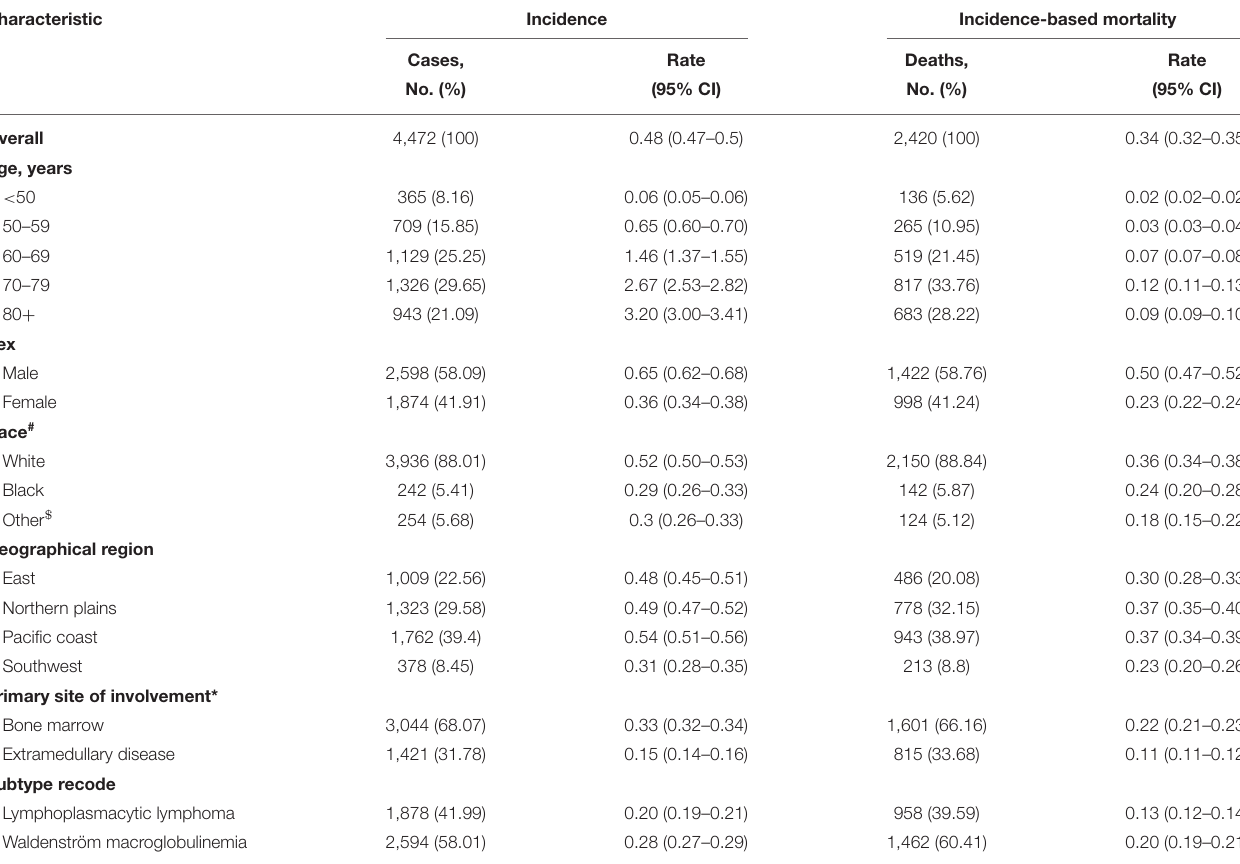
TABLE 1 | Waldenström macroglobulinemia incidence (1980–2016) and incidence-based mortality (1990–2016): the SEER-9 registry database. Characteristic